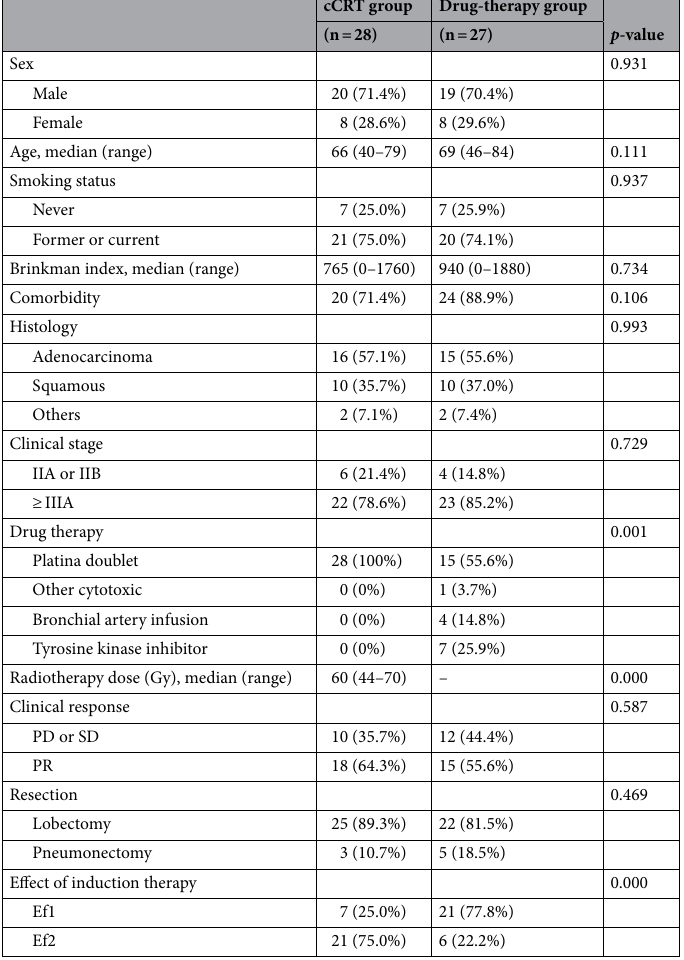
Table 1. Characteristics of patients classified by induction